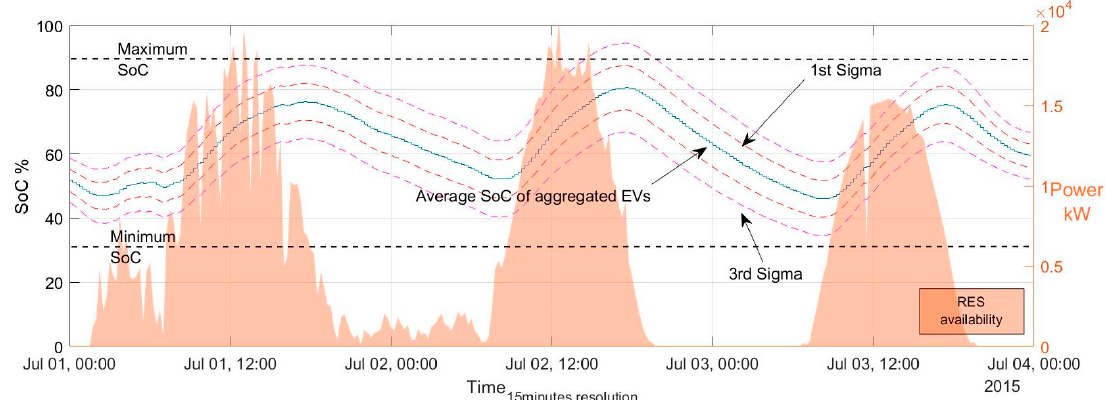
Figure 11. Average and the standard deviation of aggregated EVs’ SoC under coordinated charging/discharging management.